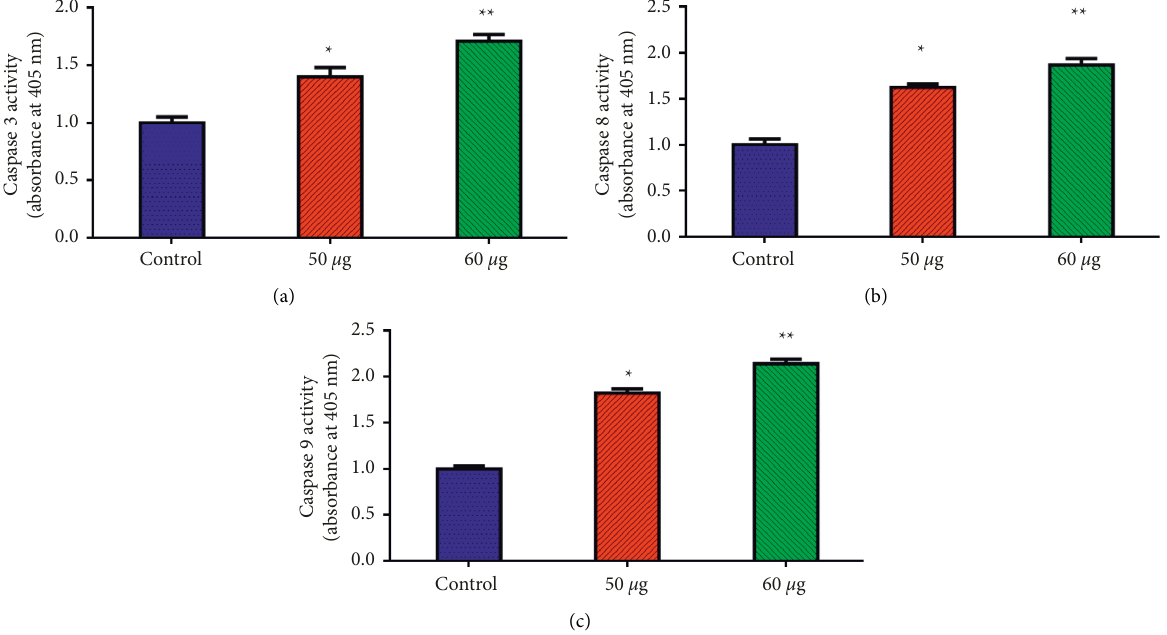
Figure 10: Effect of ZnO-TiO 2 -chitosan-farnesol NCs on caspase 3 (a), 8 (b), and 9 (c) activities in MOLT-4 cells. The cells were treated for 24h with the NCs at the dosages of 50 and 60 μ g/ml. The protein status in the culture supernatant was subsequently estimated by the ELISA technique. The outcomes were displayed as the mean ± SD of triplicates: ∗ p < 0 . 05 vs. control; ∗∗ p < 0 . 01 vs.